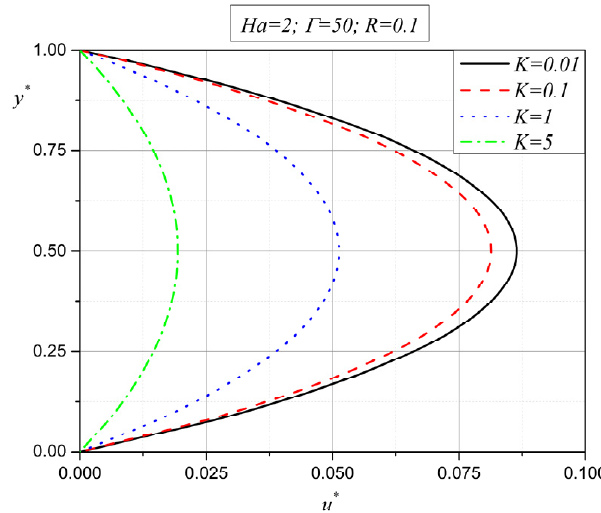
Figure 5. Influence of coupling parameter 𝐾 on velocity 𝑢 ∗ .